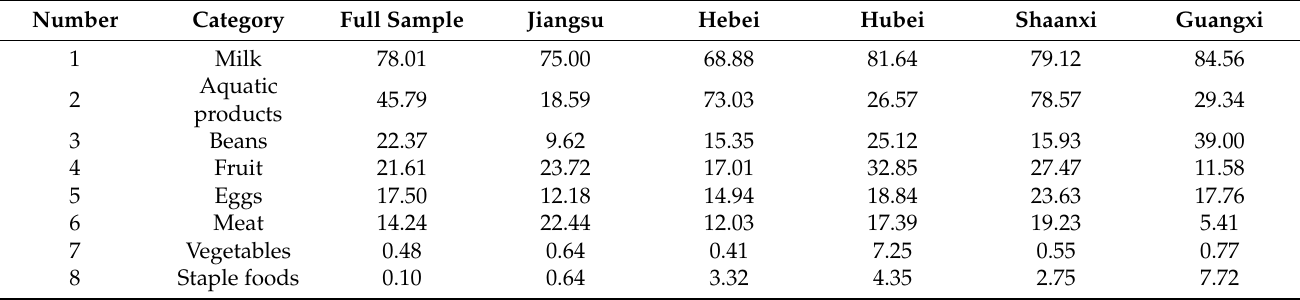
Table 2. Percentage of farmers who do not consume certain types of food in one week